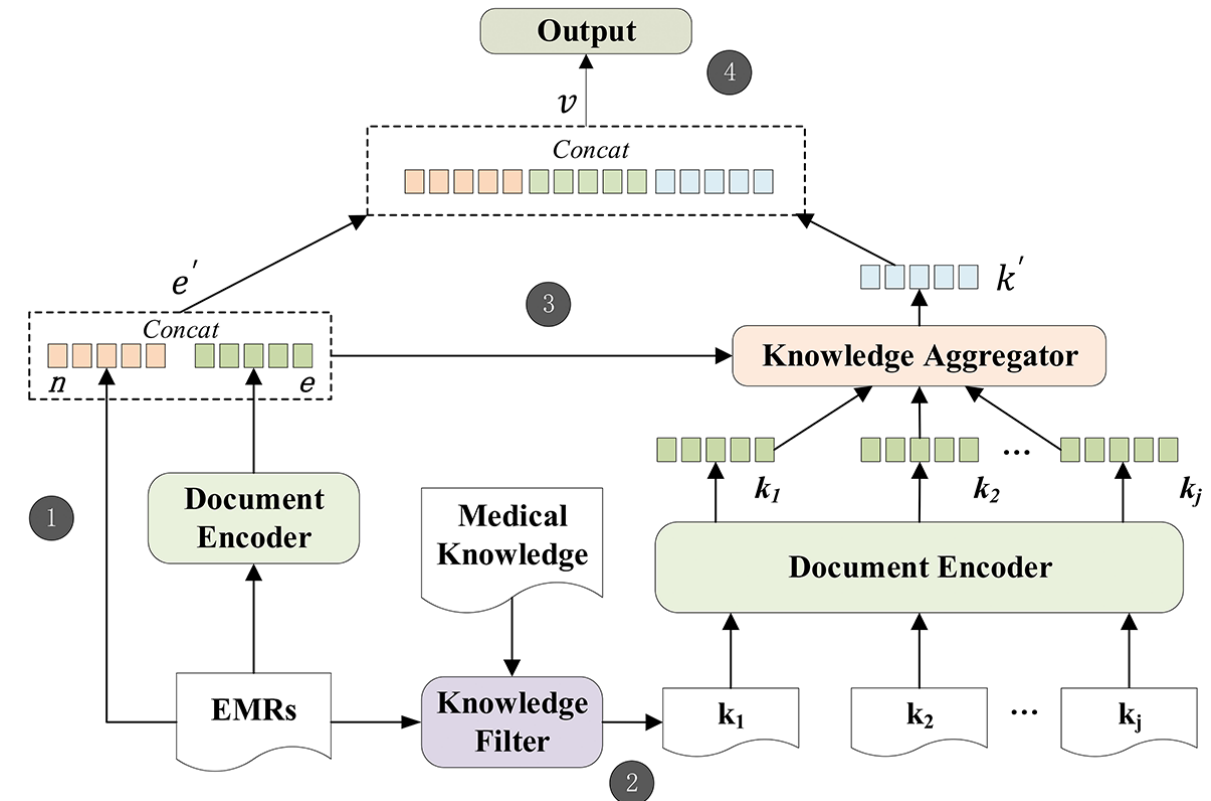
Figure 1. Overview of knowledge-aware hierarchical diagnosis